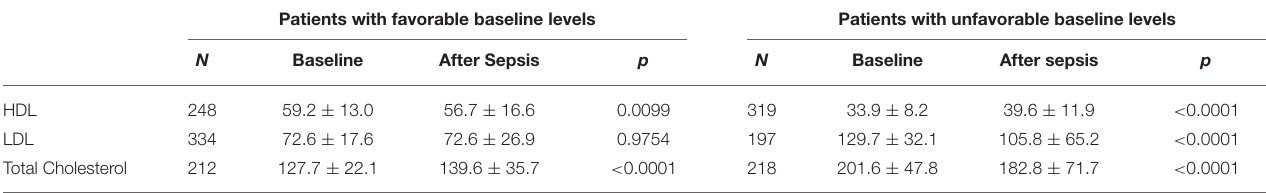
TABLE 2 | Comparisons of long-term post-septic changes in lipid profile in patients with favorable and unfavorable lipid profile prior to a septic insult. Patients with favorable baseline levels Patients with unfavorable baseline levels